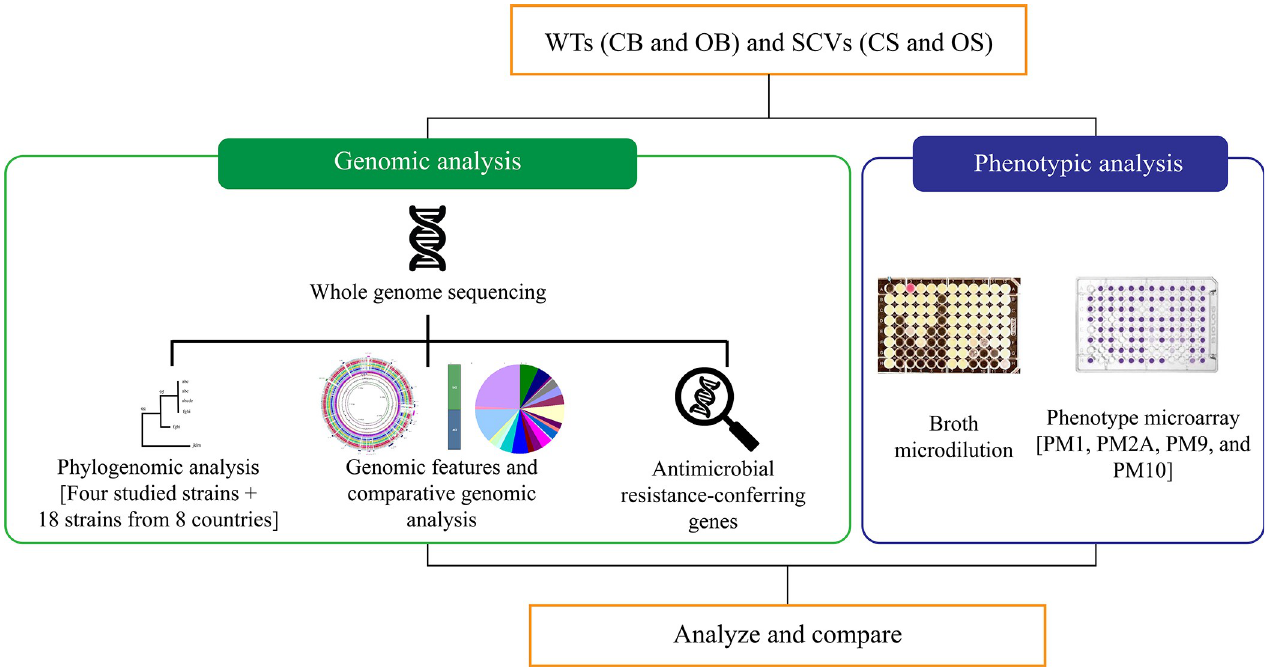
Fig 1. Overview of the study. The WTs and SCVs were subjected to genomic and phenotypic analyses, and the results were analyzed and compared.